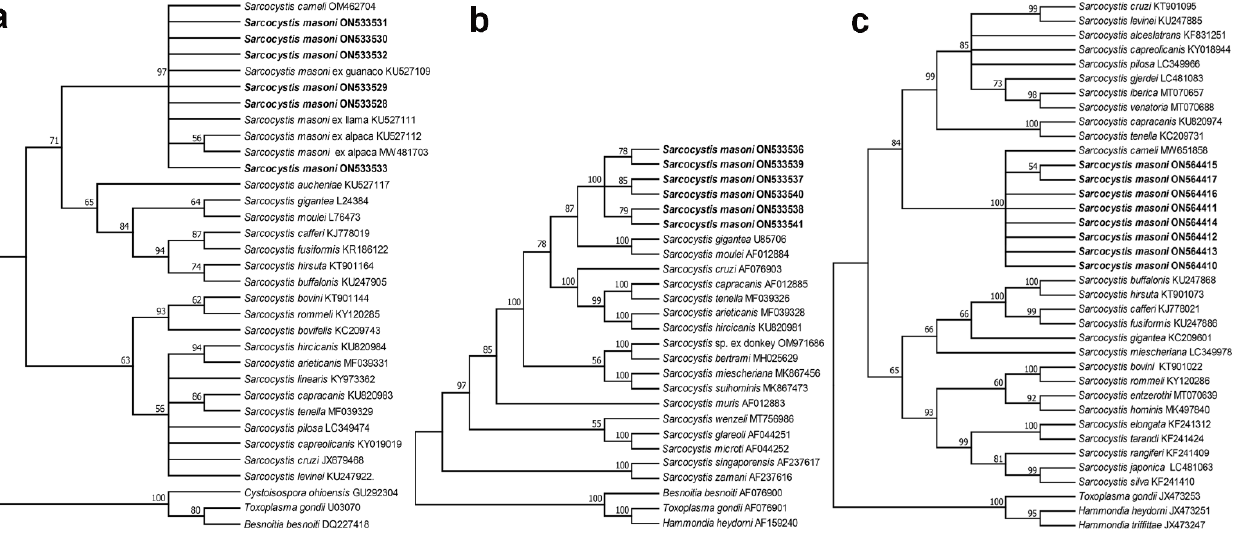
Figure 4. Phylogenetic trees of selected Sarcocystis species. The trees constructed based on ( a ) 18S rDNA sequences, ( b ) 28S rDNA sequences, and ( c ) mitochondrial cox 1 sequences using maximum likelihood (ML) with the Tamura 3-parameter, Hasegawa–Kishino–Yano, and Kimura 2-parameter models, respectively. The values between the branches represent bootstrap values per 1000 replicates, and values below 50% are not shown. ( a ) The six newly obtained 18S rDNA sequences of S . masoni (ON533528–ON533533, shown in boldface) obtained from the alpaca formed an individual clade with those of S . cameli in the one-humped camel and S . masoni in the llama, alpaca, and guanaco. ( b ) The six new sequences of S . masoni (ON533536–ON533541, shown in boldface) obtained from an alpaca formed an individual clade within a group comprising Sarcocystis spp. in domestic ruminants. ( c ) The eight sequences of S . masoni (ON564410–ON564417, shown in boldface) obtained from the alpaca and two infected dogs formed an individual clade with S . cameli in the one-humped